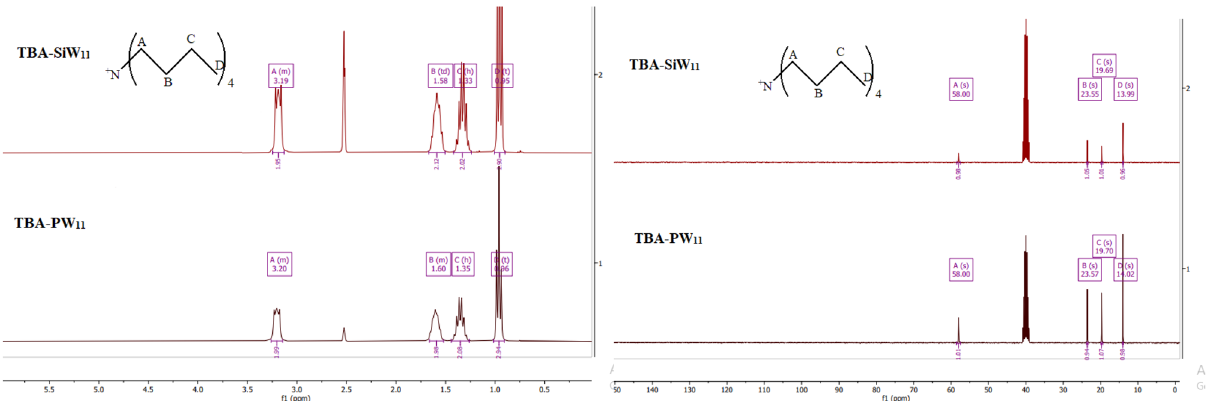
Figure 3. 1 HNMR (left) and 13 CNMR (right) spectra of TBA-PW 11 and TBA-SiW 11 .